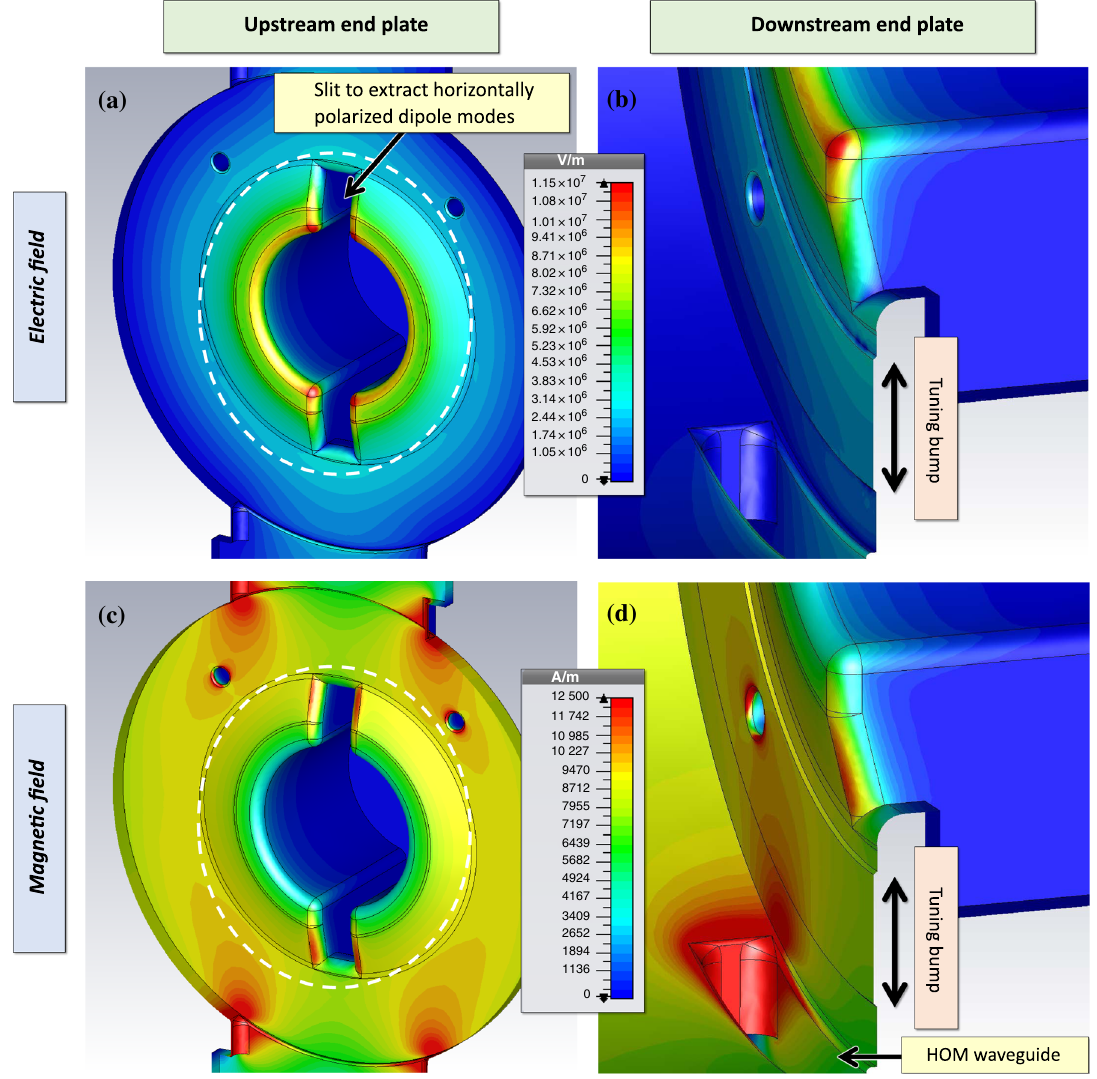
¼ 3 . 5 MV = m), where the gravitational force points vertically FIG. 6. Surface field of the accelerating mode at V c ¼ 0 . 90 MV ( E acc downward. The region inside the white dashed ellipse on the upstream end plate was observable with camera 3, and the observable region on the downstream end plate was almost the same. The maximum strengths of the electric and magnetic fields were 13 MV = m on the nose cone and 34 kA = m at the aperture for the HOM waveguide, respectively. The maximum values in the scales for the electric and magnetic fields do not correspond to the maximum field strengths but were selected for visual effect. (a) Electric field distribution on the upstream end plate. (b) Electric field distribution on the downstream end plate with a vertical cut plane. (c) Magnetic field distribution on the upstream end plate. (d) Magnetic field distribution on the downstream end plate with a vertical cut